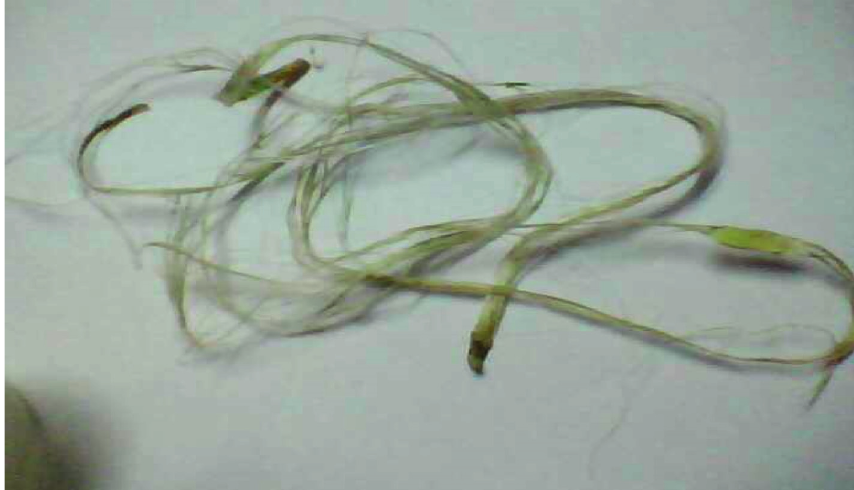
Figure 3: Extracted mudar